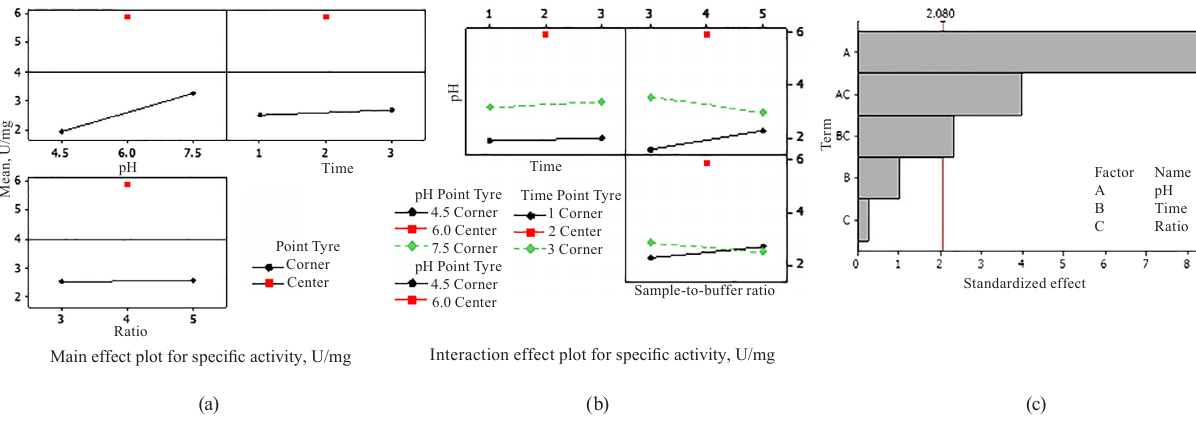
Figure 3 Main effect (a), interaction effects (b), and Pareto chart of extraction variables (c) on specific activity of amylase from white pitaya peel (c)